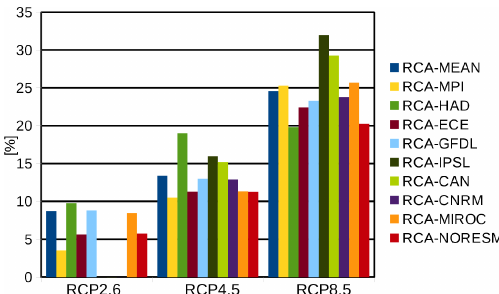
Figure 7. Relative change in moisture transport within ARs at the end of the century (2070–2099) compared to the historical pe- riod (1970–1999). RCA-MEAN denotes the mean of the individual models. Note that no RCP2.6 realizations are available for RCA- IPSL, RCA-CAN, and RCA-CNRM.